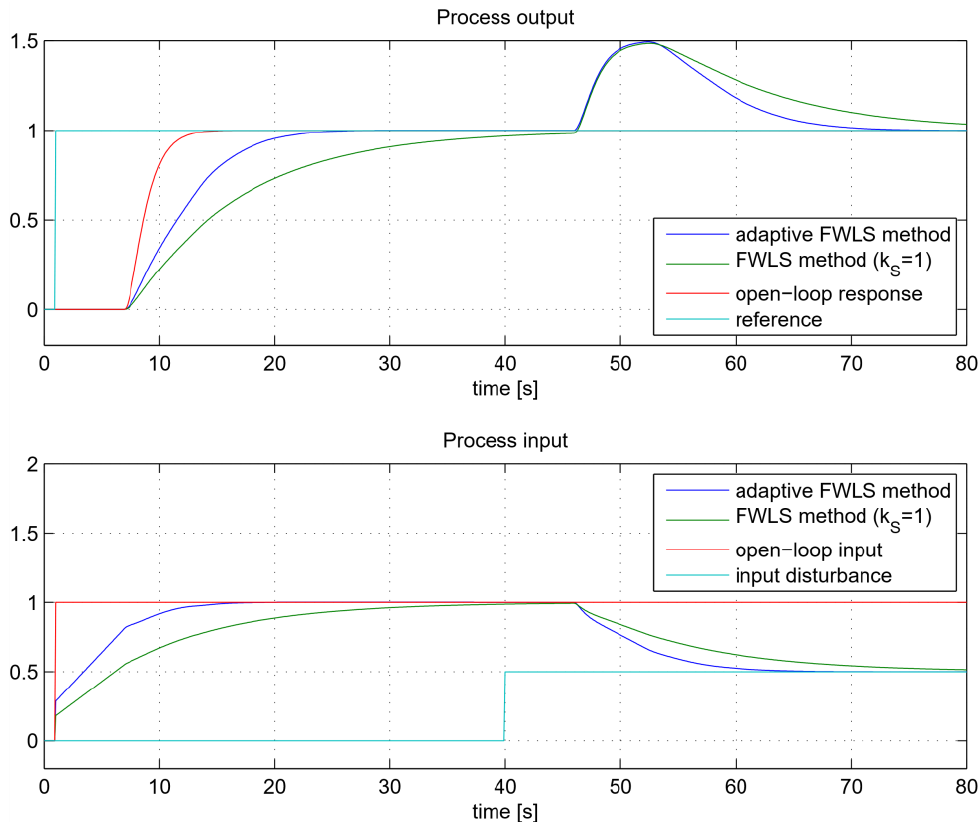
Figure 21. The closed-loop tracking and control signals for process G P 5 .